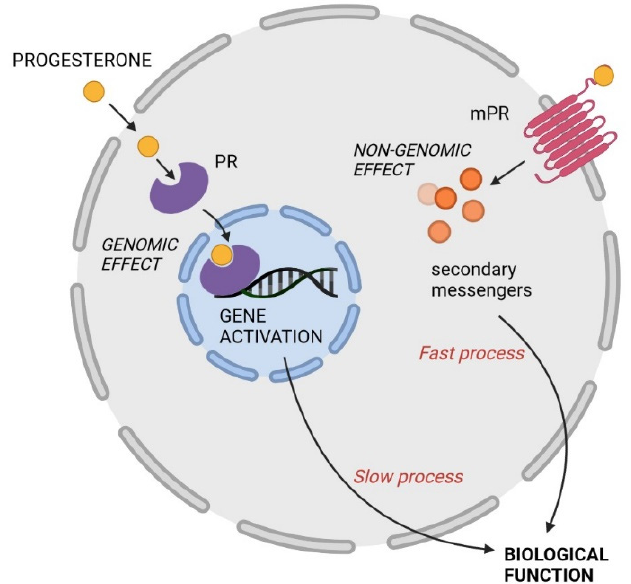
Figure 1. Modes of progesterone action by genomic and non-genomic pathways. mPR—membrane progesterone receptor. Created with BioRender.com.